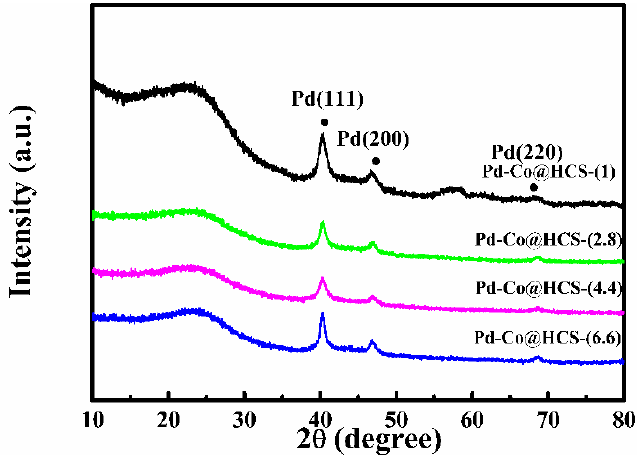
Figure 5. XRD patterns of Pd-Co@HCS-(X).